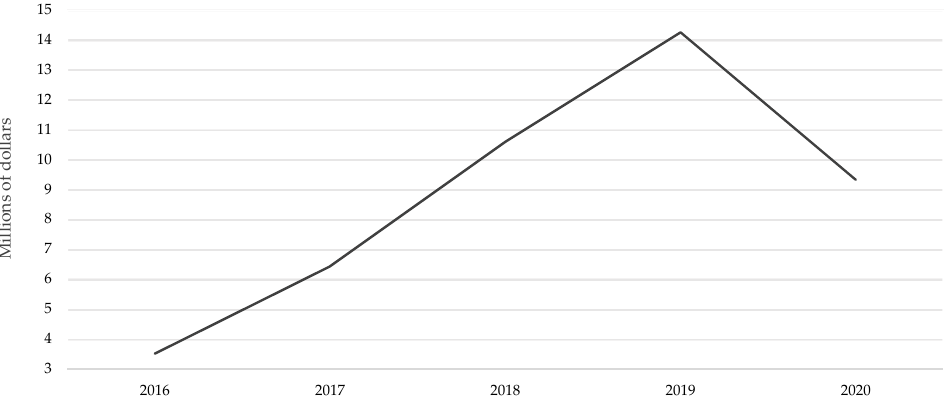
Figure 1. Start-ups investments in India. Source: Adapted from ET-TECH [19].